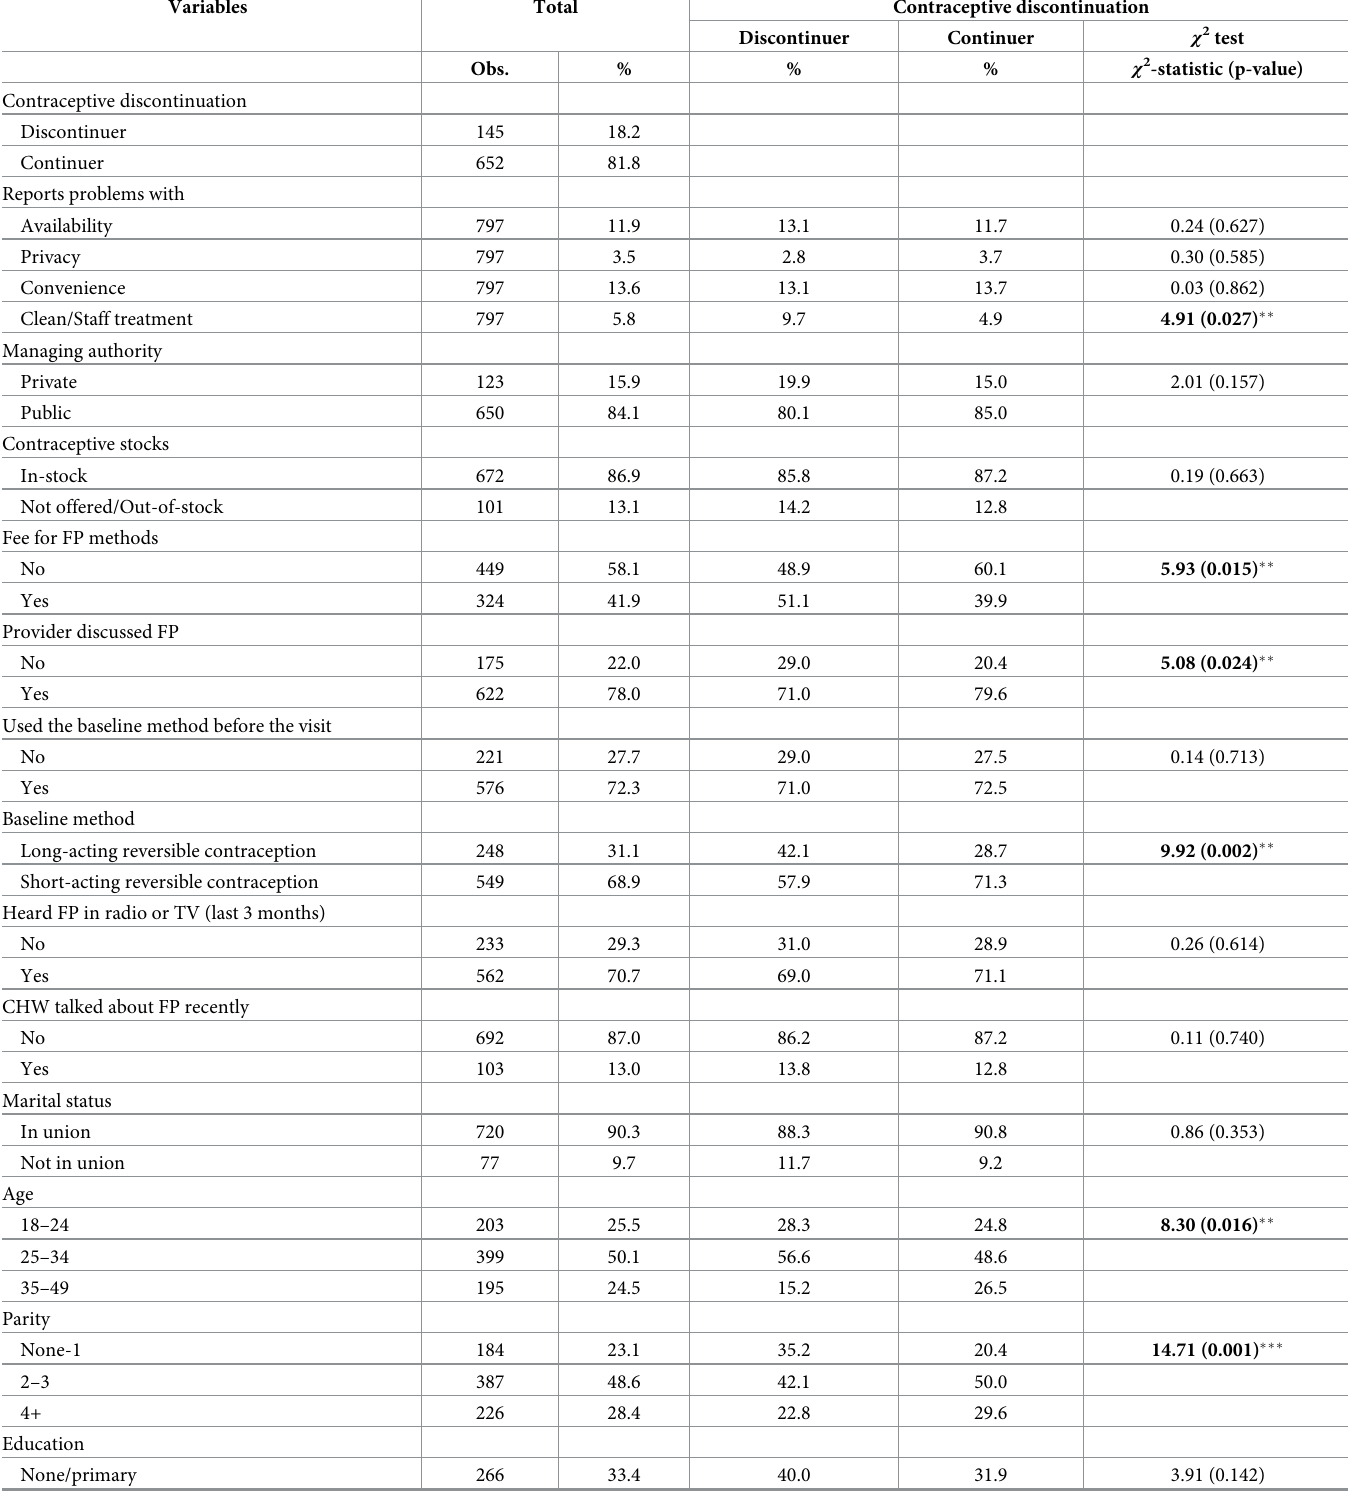
Table 2. Sample characteristics of family planning clients stratified by contraceptive discontinuation